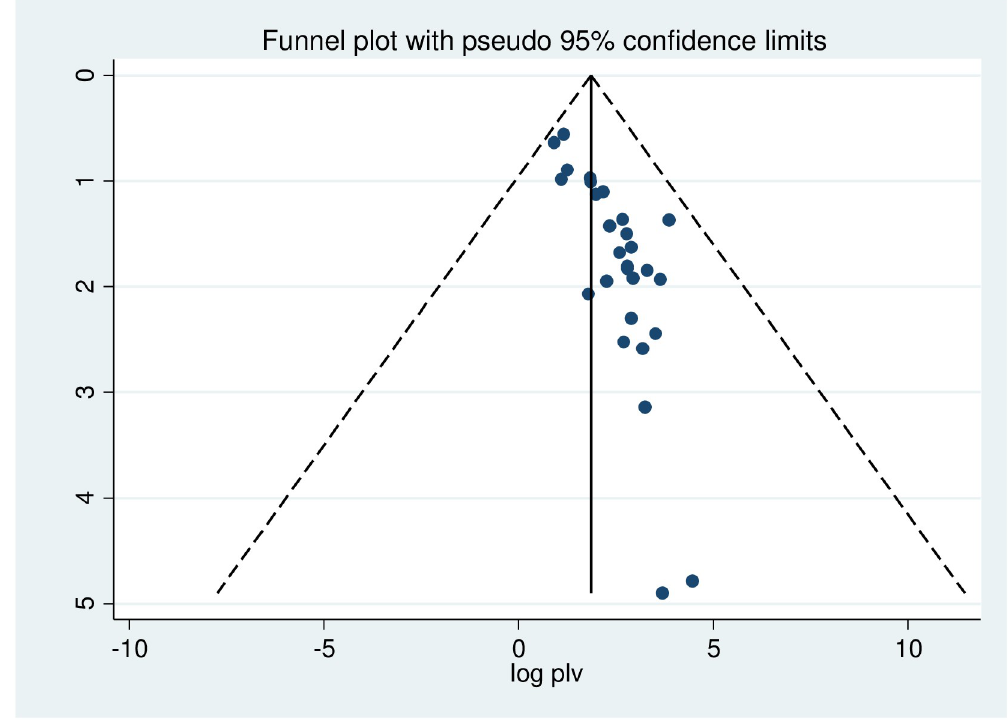
Fig 4. Funnel plot to test the publication bias in 28 studies with 95% confidence limits.